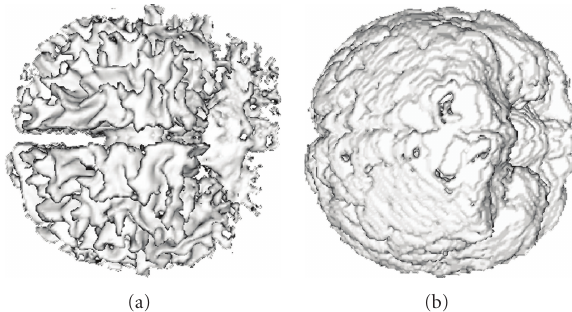
Figure 16: 3D segmentation results of (a) WM and (b) GM for one real brain data of T 1 -weighted